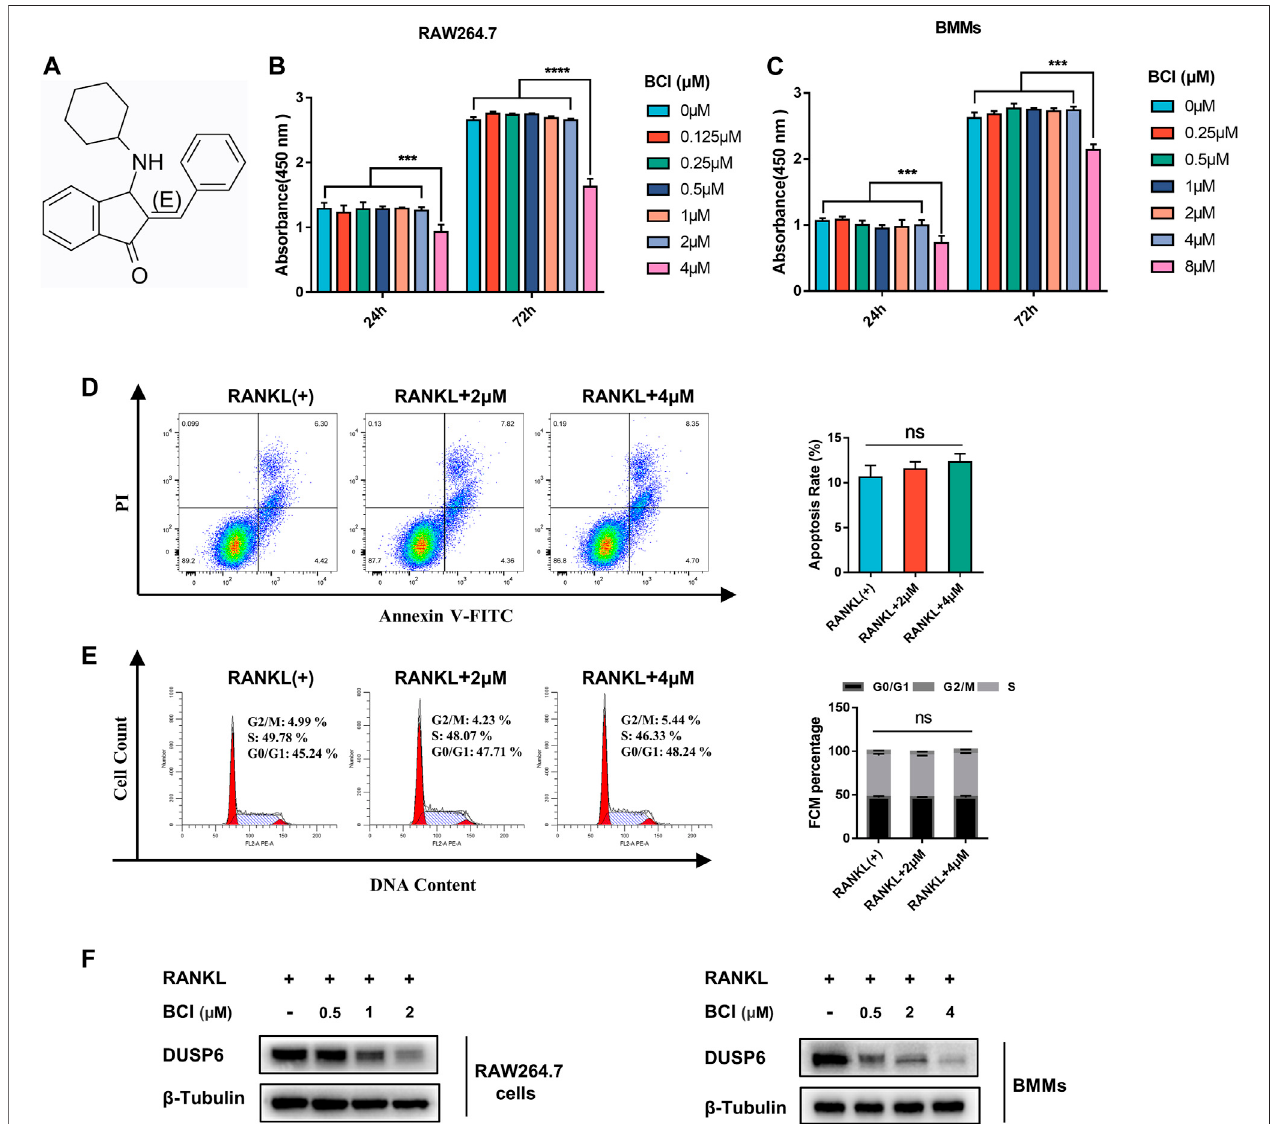
FIGURE1| TheeffectsofBCItreatmentoncellcycle,viability,andapoptosis. (A) ChemicalstructureofBCI. (B,C) RAW264.7cellsandBMMs inducedbyRANKL andM-CSFweretreatedwithvariousconcentrationsofBCIfor1and3 days,followedbyCCK-8assaystoassesscellviability. (D,E) Flowcytometricanalysistoevaluate apoptosis and cell cycle progression of BMMs treated with or without BCI. (F) Con fi rmation of BCI-mediated suppression of DUSP6 expression in RAW264.7 cells and BMMs during RANKL-mediated osteoclast differentiation. * p < 0.05, ** p < 0.01, *** p < 0.001.